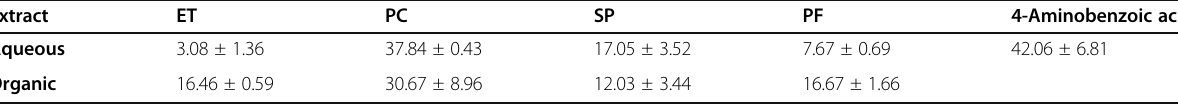
Table 4 Sun protection factor of the plant extracts Extract ET Aqueous Organic Values = mean ± SD, n =